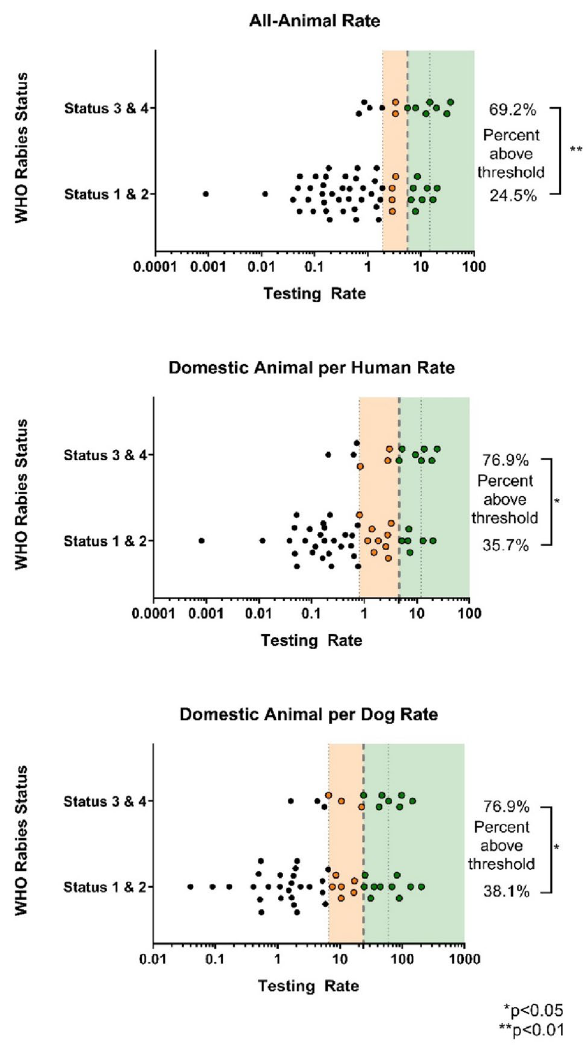
Figure 3. Animal Testing Rate Thresholds. Individual points represent countries with available testing data. The orange section represents any value between the first and second quartile, where the first quartile is the proposed threshold. The green section represents anything at or above the second